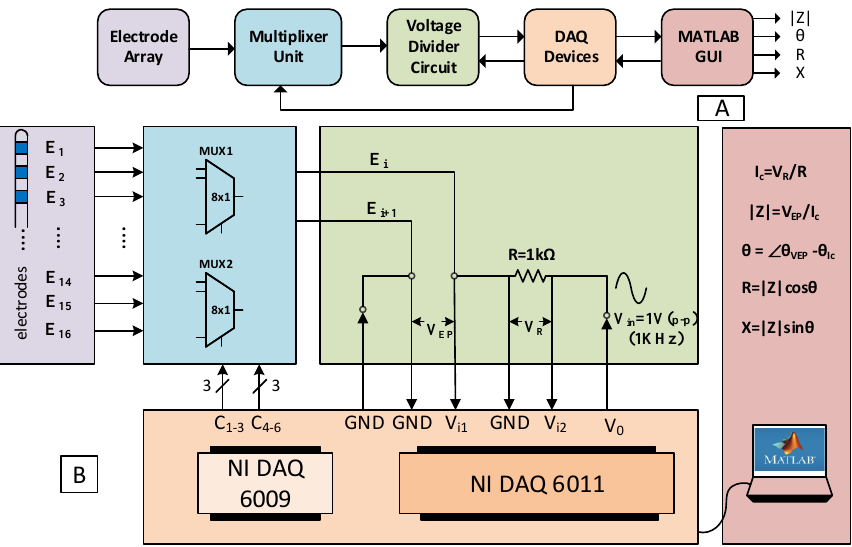
Figure 3. ( A ) Impedance measurement setup configuration chain, ( B ) detailed block/circuit diagram for the complex impedance measurement system. The diagram is colour-coded according to the sections of the